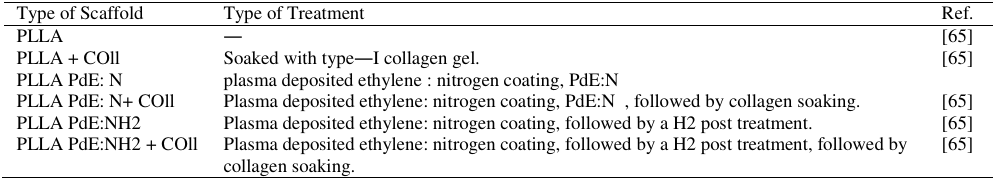
Fig. 6. Scheme of the coelectro - spinning [30]. Figure 6 : Scheme of the coelectro ― spinning [30]. Table 2 : Name and type of PLA scaffolds. Table 2. Name and type of PLA